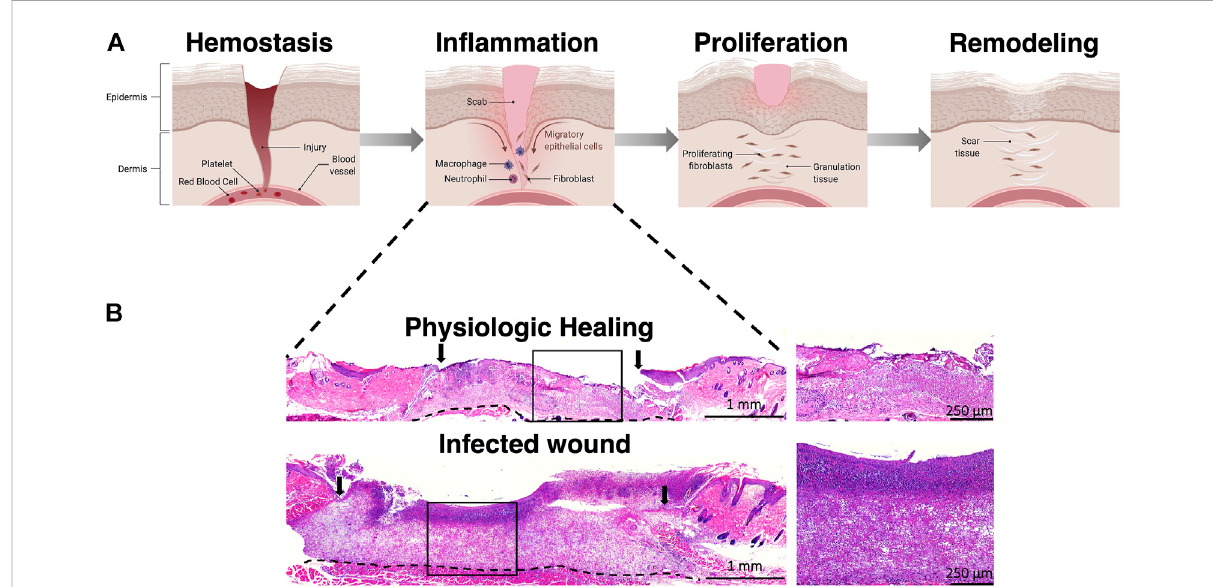
FIGURE 1 Phases of wound healing. (A) Wound healing progresses through four phases including hemostasis, in fl ammation, proliferation, and remodeling. (B) Representative H&E staining of wounds in the in fl ammation stage demonstrating poor granulation tissue formation in an infected wound. Arrows represent wound edge. Illustration created using